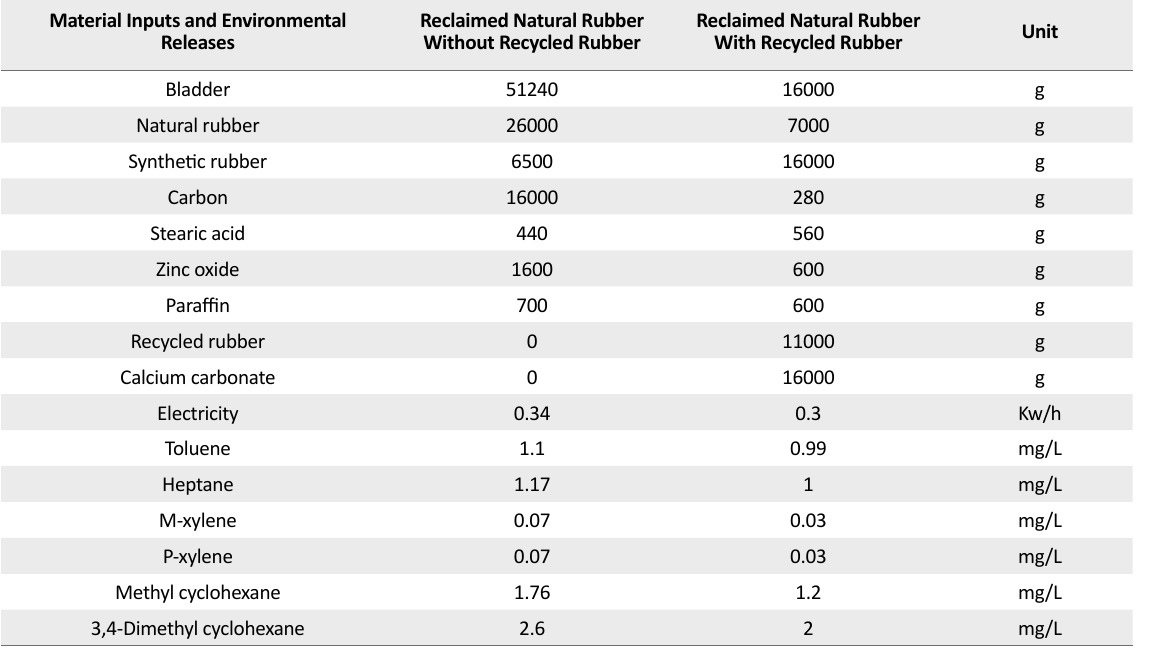
Table 1. Inventory for ball manufacturing using bladder with natural rubber and bladder with recycled+natural rubbers Material Inputs and Environmental Releases